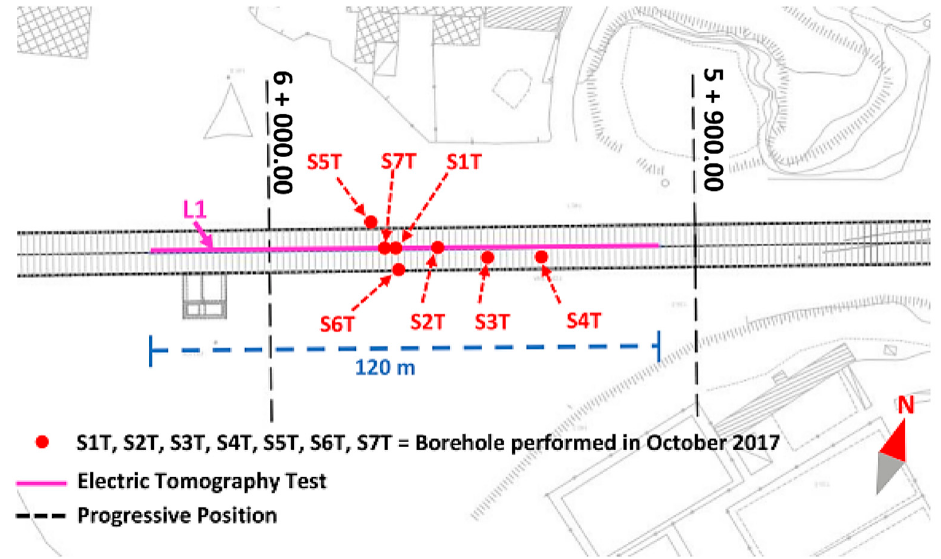
Figure 13. Zoom of the soil profile: ( a ) established during the design phase (see Figure 12c); ( b ) updated during tunnelling (see Figure 12d).